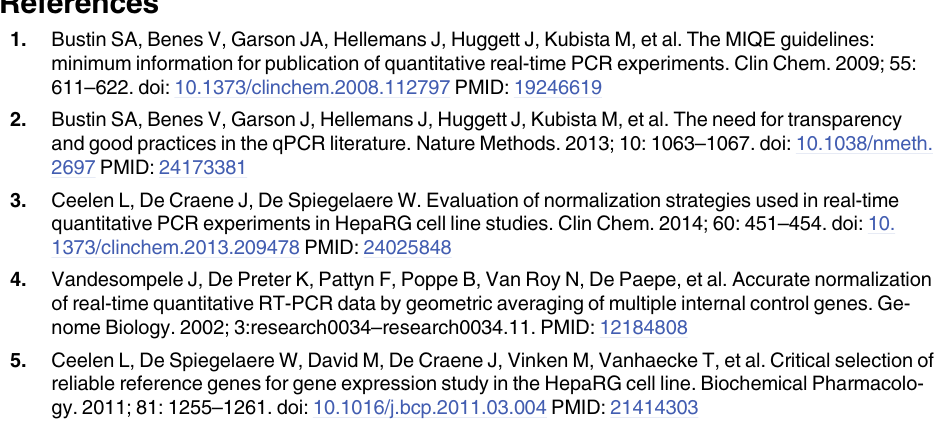
S1 Table. Raw Cq values. S2 Table. Efficiencies of the different primer sets. S3 Table. Stability measures from all algorithms for the FS1 samples. S4 Table. Stability measures from all algorithms for the CIS